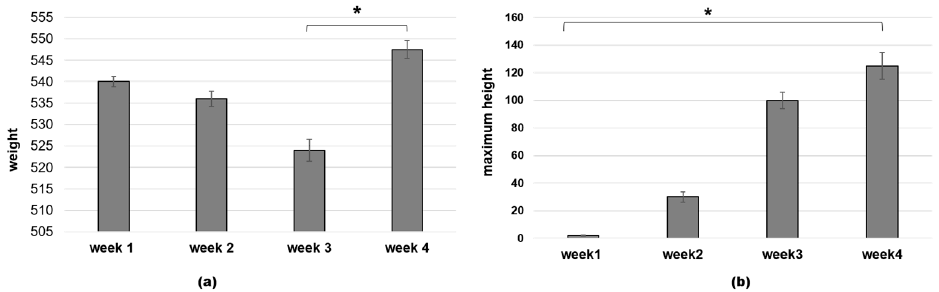
Figure 4. Peregrine falcon’s achievements during the habituation cycle. Median ± standard error of weight; and ( a ) maximum height ( b ). Wilcoxon test for non ‐ parametric data, results are given as a range * W = 0, p < 0.001.